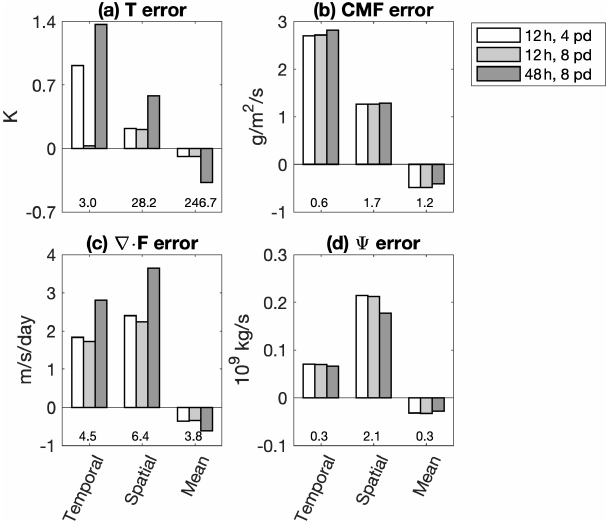
Figure 19. Global average temporal, spatial, and mean errors in (a) temperature, (b) convective mass flux, (c) Eliassen–Palm flux di- vergence, and (d) TEM residual streamfunction in specified dynam- ics simulations nudged to NASA GEOS5 meteorology, for three dif- ferent nudging parameter configurations. Numbers under each set of bars indicate the global average temporal or spatial standard devia- tion or mean value for each